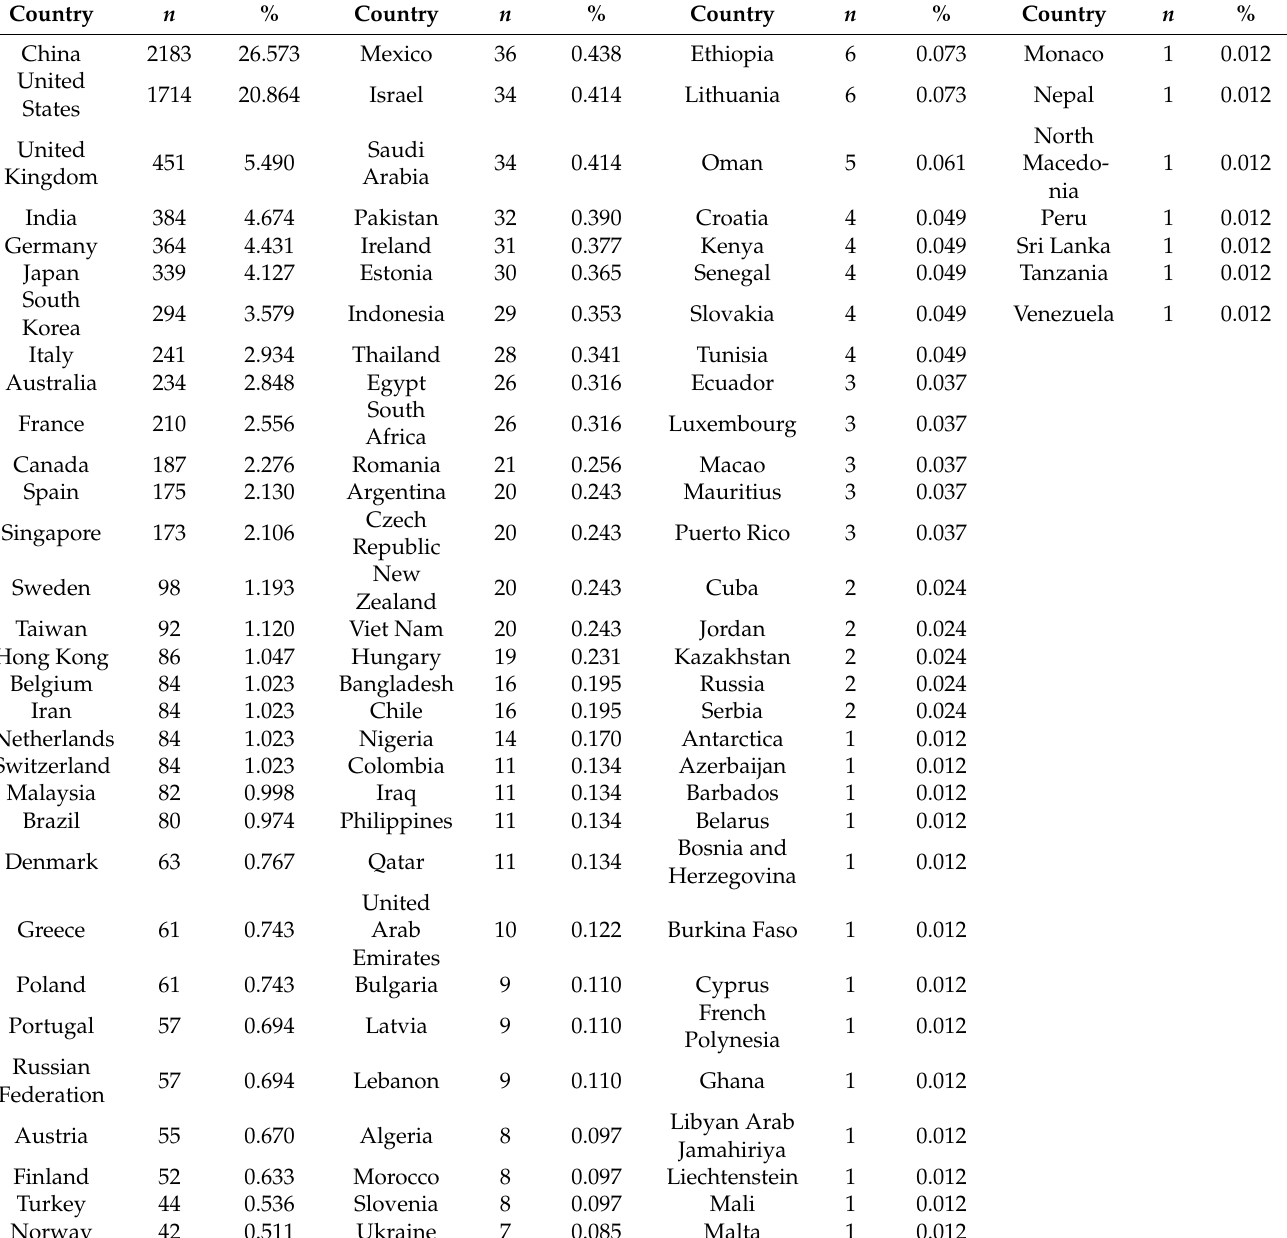
Table A2. Complete list of countries and their total number of issued scientific papers ( n ) as well as their relative percentage.